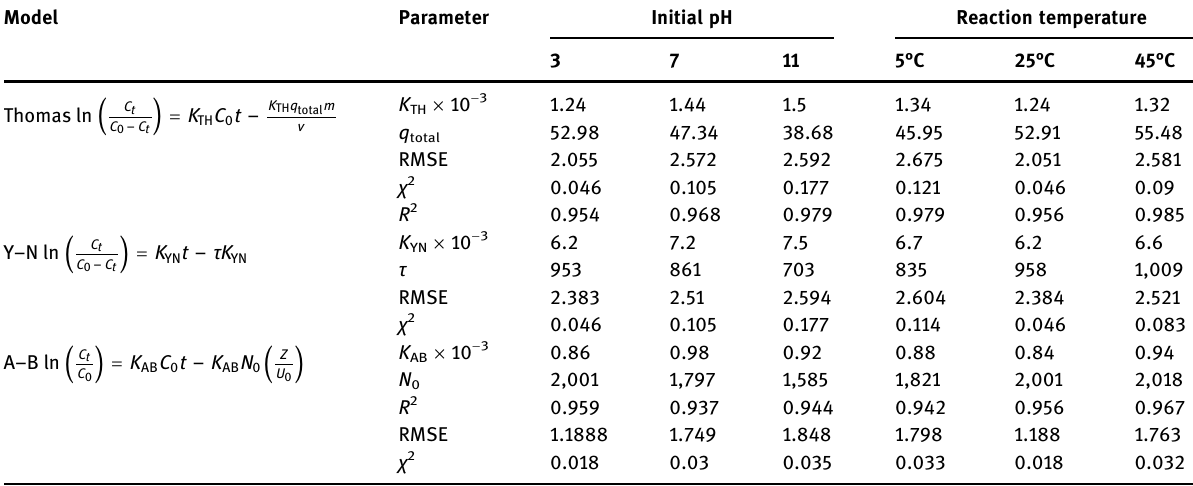
Table 3: Parameters estimated by the Thomas, Y – N, and A – B models in various experimental conditions